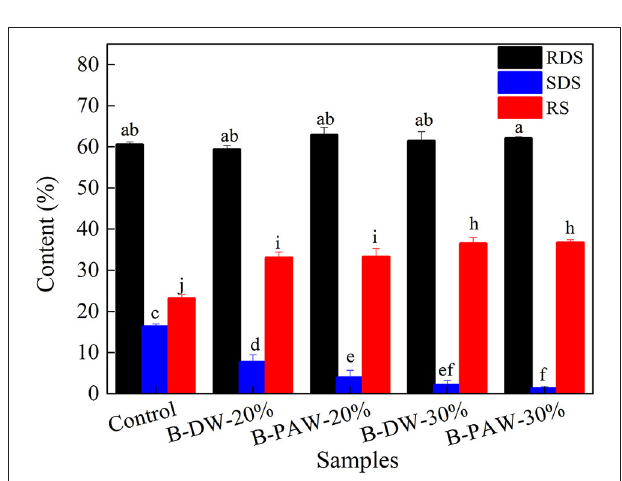
FIGURE 4 | Effect of modified flour on the digestion of steamed bread. Different lowercase letters indicate significant differences at p <